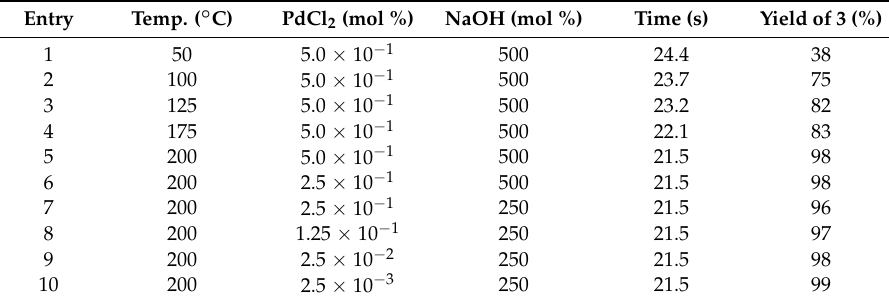
Table 1. SMC in HPHT water 1